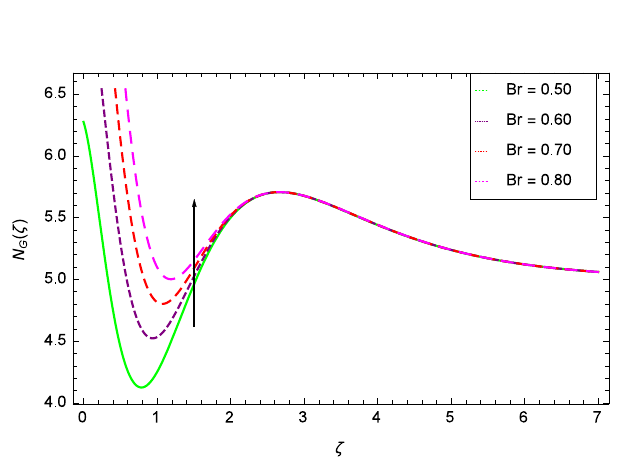
Figure 37. Parameter effect on entropy generation rate N G ( ζ ) profile.